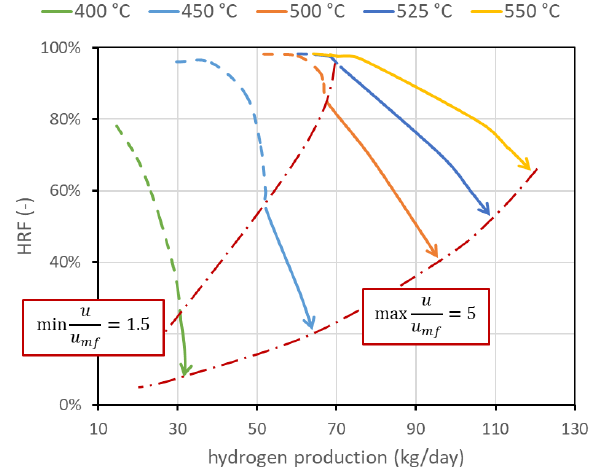
Figure 5. Performance chart with lines at different reactor temperatures. It appears clear that temperature strongly affects performance, and how it is important to increase its value to increase both HRF and hydrogen production. Temperature upper limit is due to membrane stability. Nominal value is 500 °C.